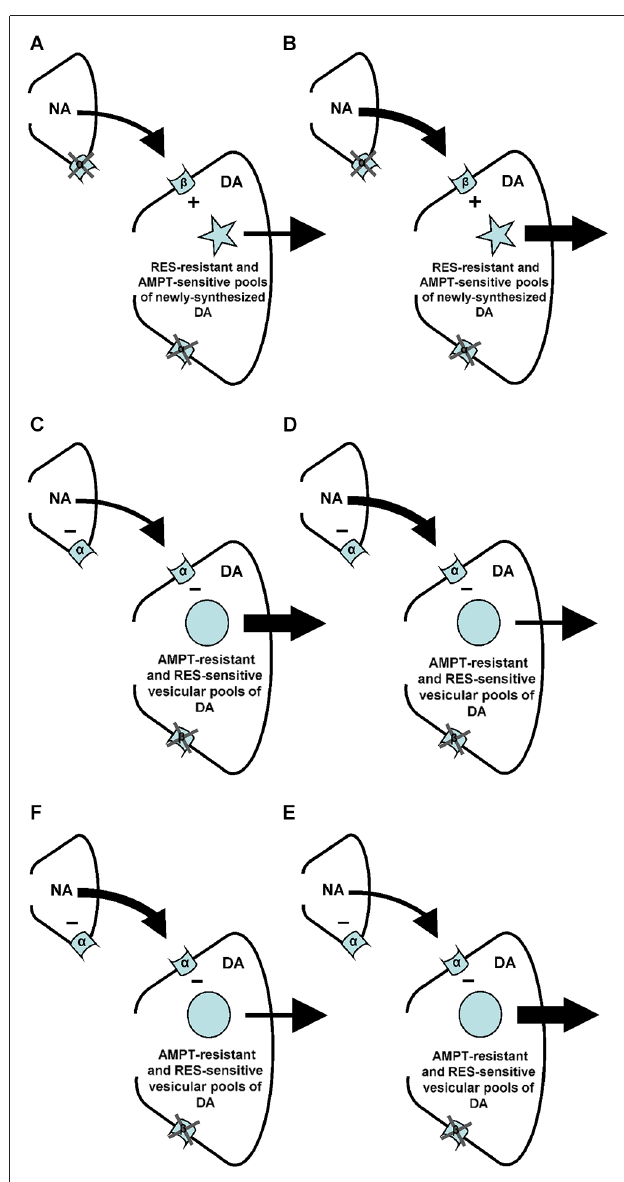
FIGURE 8 | Summary of the findings of the present and previous studies . Changes in arrow weight represent changes in noradrenaline (NA) and/or DA release. (A–B) An increase of NA at the level of the postsynaptic beta ( β )-, but not alpha ( α )-adrenoceptors of the nucleus accumbens stimulates (+) accumbal DA release from AMPT-sensitive pools of newly-synthesized DA (present study) that are resistant to RES (see: Verheij and Cools, 2009b). (C–D) An increase of NA at the level of the postsynaptic alpha-, but not beta-adrenoceptors of the nucleus accumbens inhibits (–) accumbal DA release from RES sensitive vesicular DA pools (see: Verheij and Cools, 2009b) that are resistant to AMPT (present study). (E–F) The presynaptic alpha-adrenoceptors of the nucleus accumbens (see: Tuinstra and Cools, 2000; Verheij and Cools, 2009a) are known to inhibit (–) accumbal NA release (see: Aono et al., 2007). The present study indicates that this reduction of accumbal NA leads to an increase of accumbal DA (see also: Tuinstra and Cools, 2000; Verheij and Cools, 2009a) because the noradrenergic neurons containing presynaptic alpha-adrenoceptors impinge upon dopaminergic neurons equipped with postsynaptic alpha-, but not